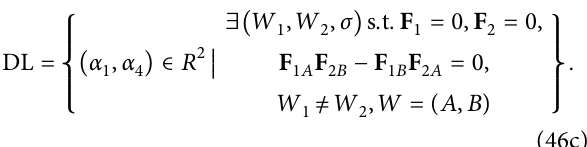
Figure 5: Amplitude frequency curves for the bifurcation mode of the region I in Figure 4 ( k the LP rotor. (b) For the HP rotor. Solid lines represent stable solutions, and dotted lines represent unstable